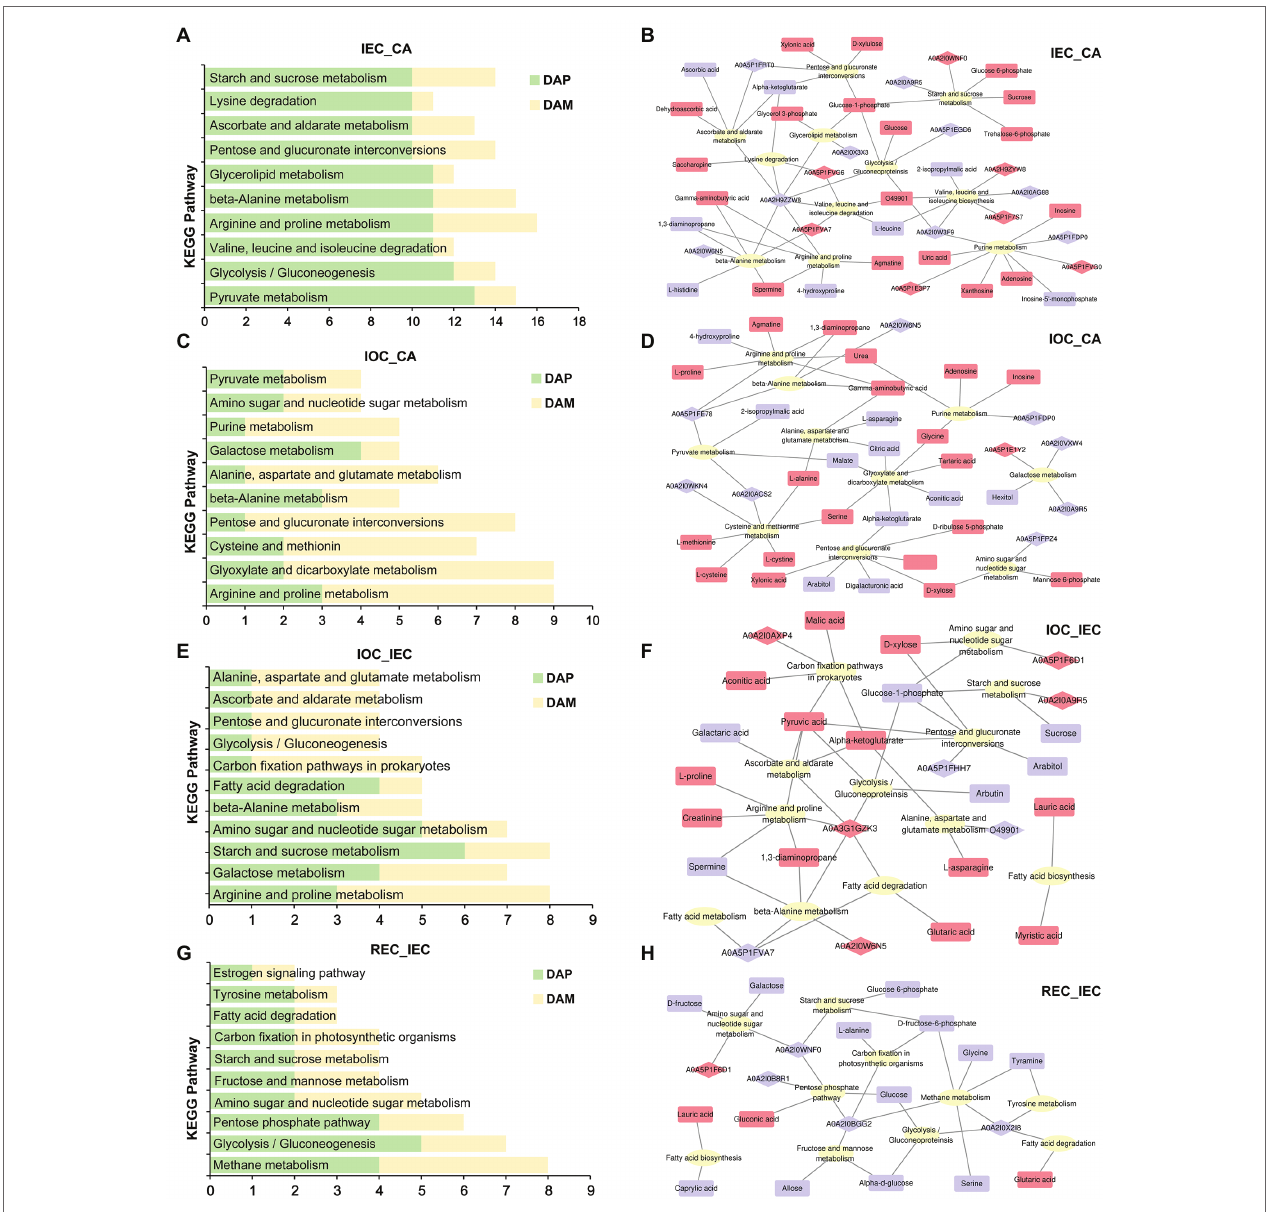
FIGURE 5 | Pathway enrichment of DAPs/DAMs and KEGG pathway XML (KGML) analyses on cell differentiation. (A) Pathway enrichment in IEC/CA; numbers presented the amounts of DAPs and DAMs, herein after. (B) KGML network of DAPs and DAMs in IEC/CA comparison. The ellipse, diamond, and chamfered rectangle indicate pathways, proteins, and metabolites, respectively. Red and blue indicate DAPs and DAMs over-accumulated or down-accumulated, herein after. (C) Pathway enrichment in IOC/CA comparison. (D) KGML network of DAPs and DAMs in IOC/CA comparison. (E) Pathway enrichment in IOC/IEC comparison. (F) KGML network of DAPs and DAMs in IOC/IEC comparison. (G) Pathway enrichment in REC/IEC comparison. (H) KGML network of DAPs and DAMs in REC/ IEC